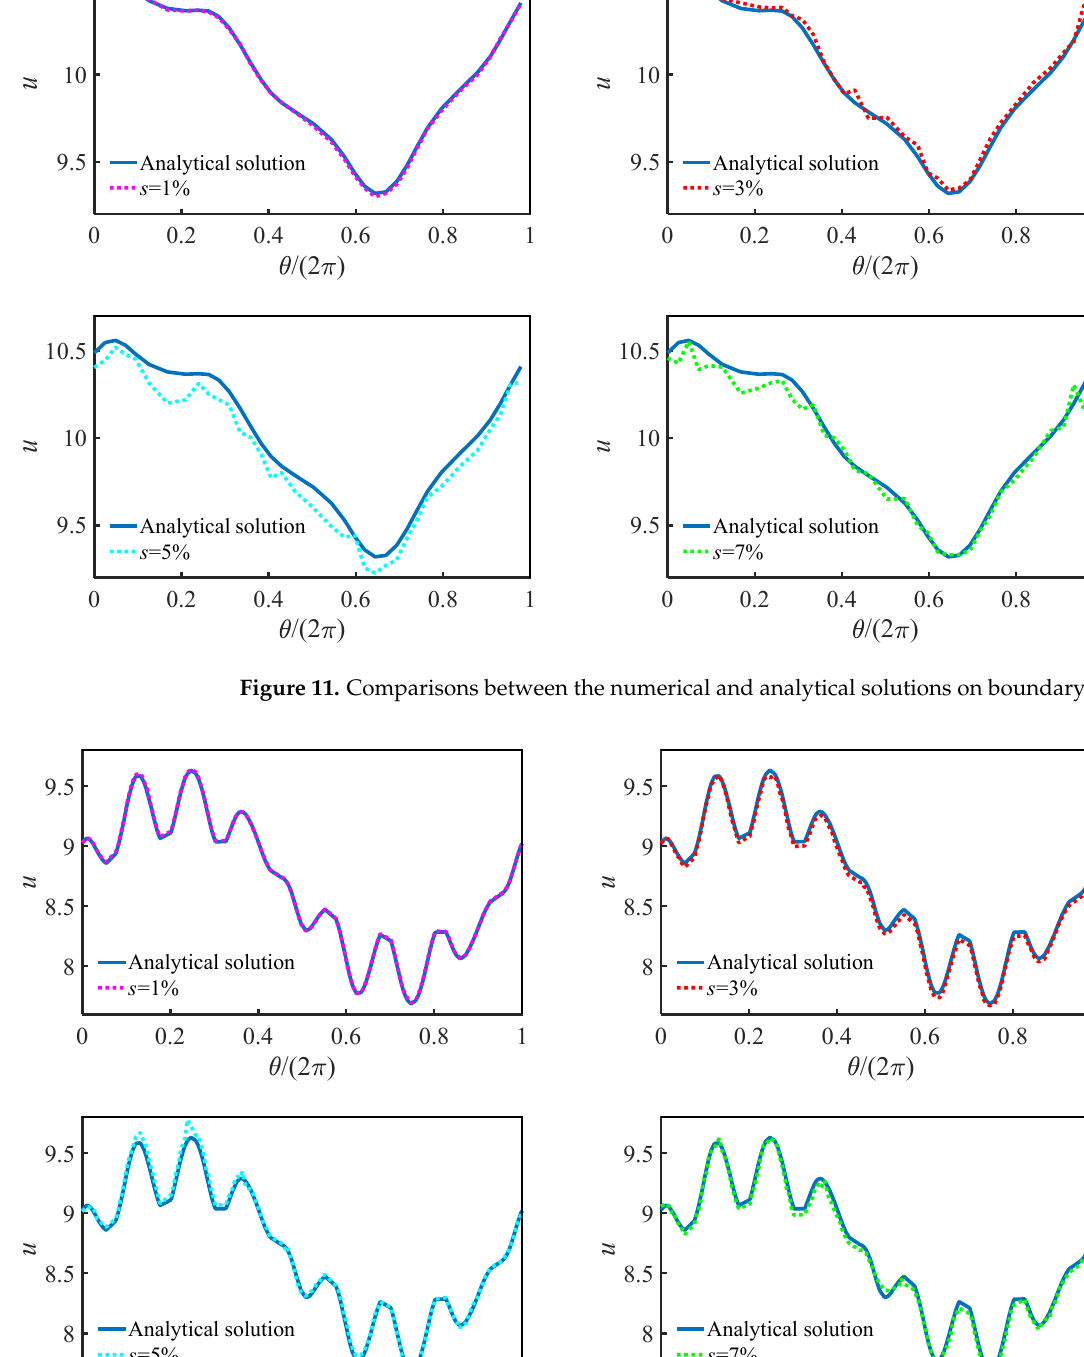
Γ Γ . Figure 12. Comparisons between the numerical and analytical solutions on boundary 3 3